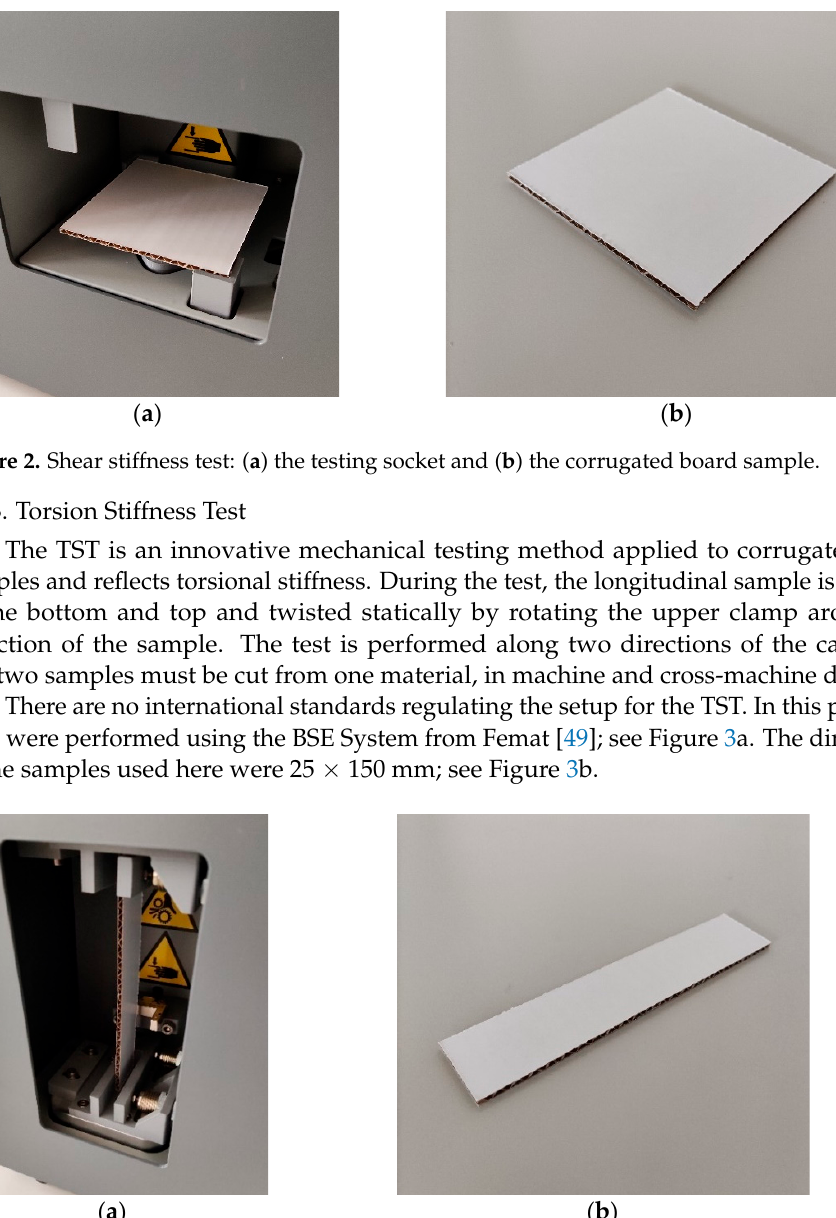
( b ) Figure 4. Bending stiffness test: ( a ) the testing socket and ( b ) the corrugated board sample. 2.2. Compression Test of Corrugated Board Packaging The BCT is the most widely known mechanical testing method and reflects the com- pressive strength of a box. There are multiple international standards for this testing method, although the general principle is similar, i.e., the box sample is placed between two rigid steel plates and compressed by pressing the upper plate on the box. The international standards one may use for the BCT setup include ISO 12048, ASTM D642, or ASTM D4169-16. In this paper, the ISO 12,048 standard was adopted for the BCT by employing a mechanical press from Femat [49]; see Figure 5a. After production, the